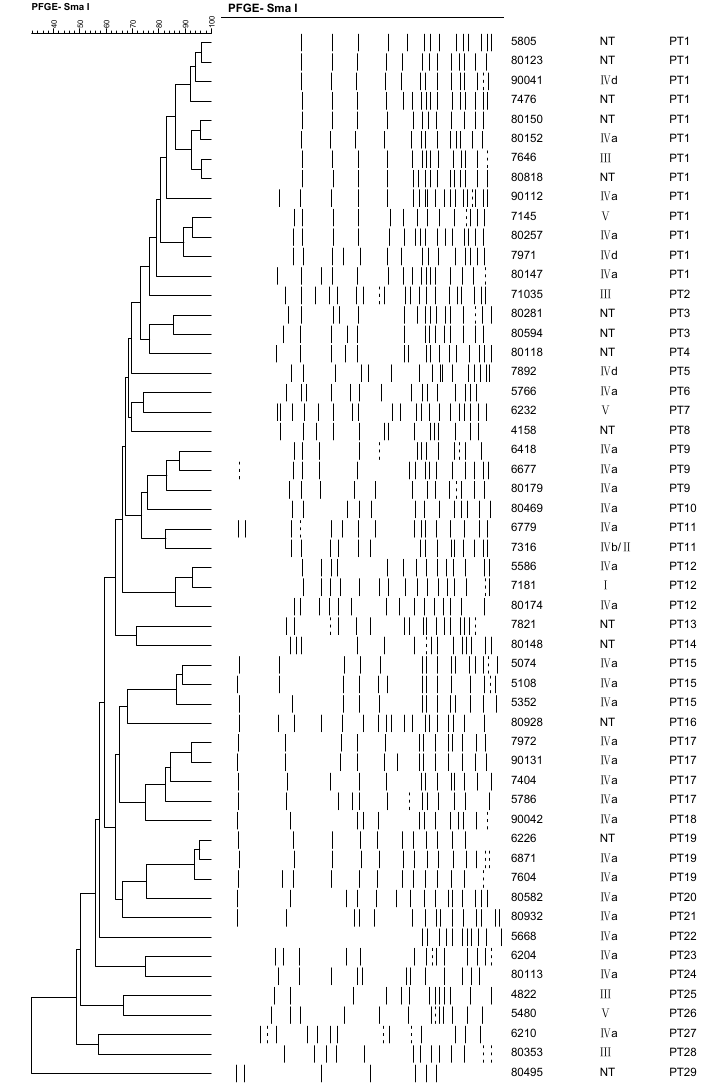
Figure 1. Dendrogram of pulsed-field gel electrophoresis patterns of MRSE isolates. At a Dice similarity index of 79%, 29 PFGE types were identified. The strain number, the SCC mec type, and the PFGE type are indicated at the right of the dendrogram.